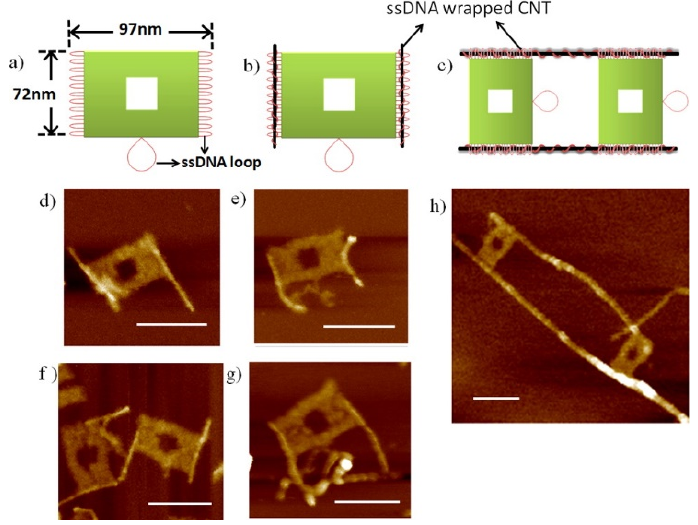
Figure 7. Schematic representations and AFM images of structures fabricated with ssDNA-SWNT hybrids using the DNA origami technique, generated by Mangalum et al. (Reprinted from reference [193] with